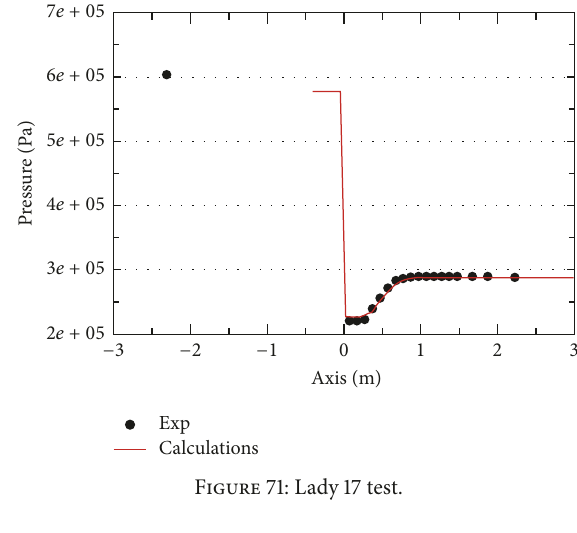
Figure 71: Lady 17 test.